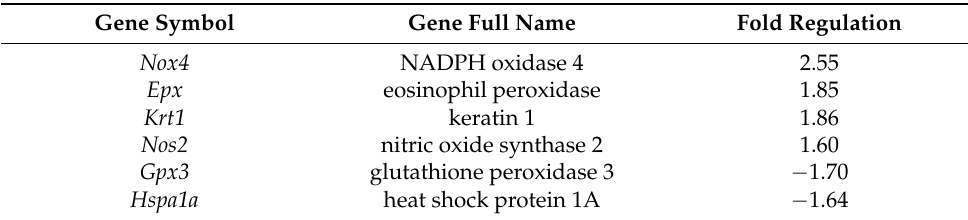
Table 1. Differentially expressed genes in HMF group mice vs. GMF group